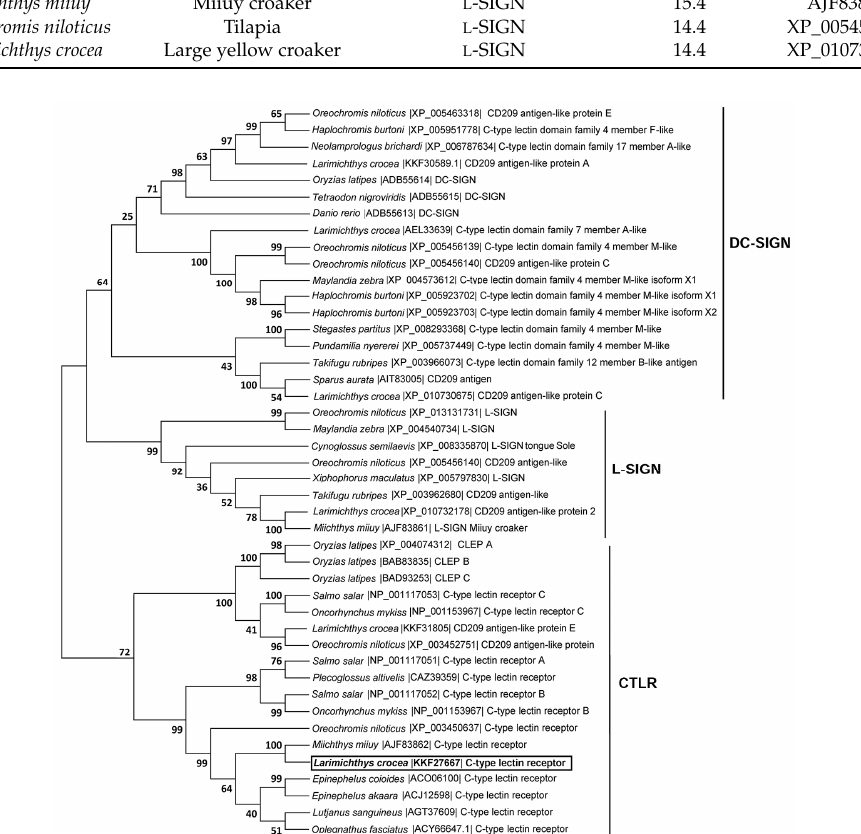
Figure 2. Phylogenetic tree based on the genetic distances of deduced amino acid sequences of fish CTLR, DC-SIGN, and L-SIGN. Deduced amino acid sequences of fish CTLR, DC-SIGN, and L-SIGN were aligned using CLUSTAL X, and the tree was constructed with the neighbour-joining method by MEGA 6.0 software [19]. Numbers on nodes represent frequencies with which the node is recovered per 100 bootstrap replications in a total of 10,000. The LycCTLR is boxed and in bold. The GenBank accession numbers of the sequences used here are shown in the figure.